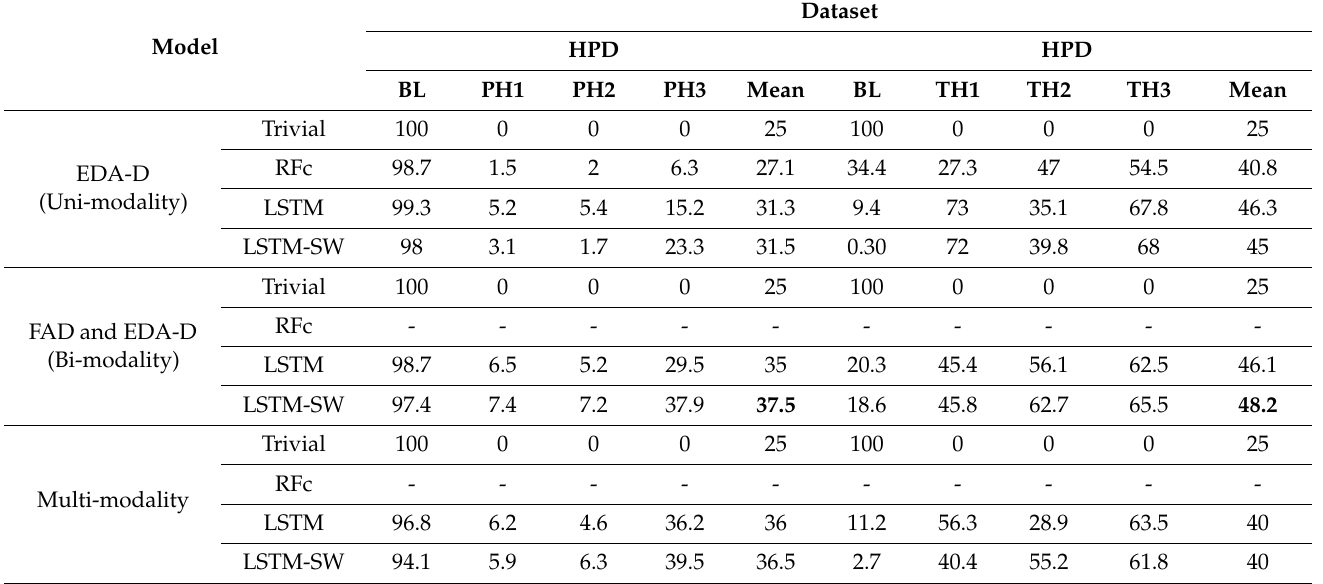
Table 9. Recall% result of 4-Class continuous pain intensity recognition tasks of HPD and HTD on testing set. Uni-modality refers to EDA-D Uni-modality, Bi-modality refers to EMG and EDA-D Bi-modality. The bold font indicates the best